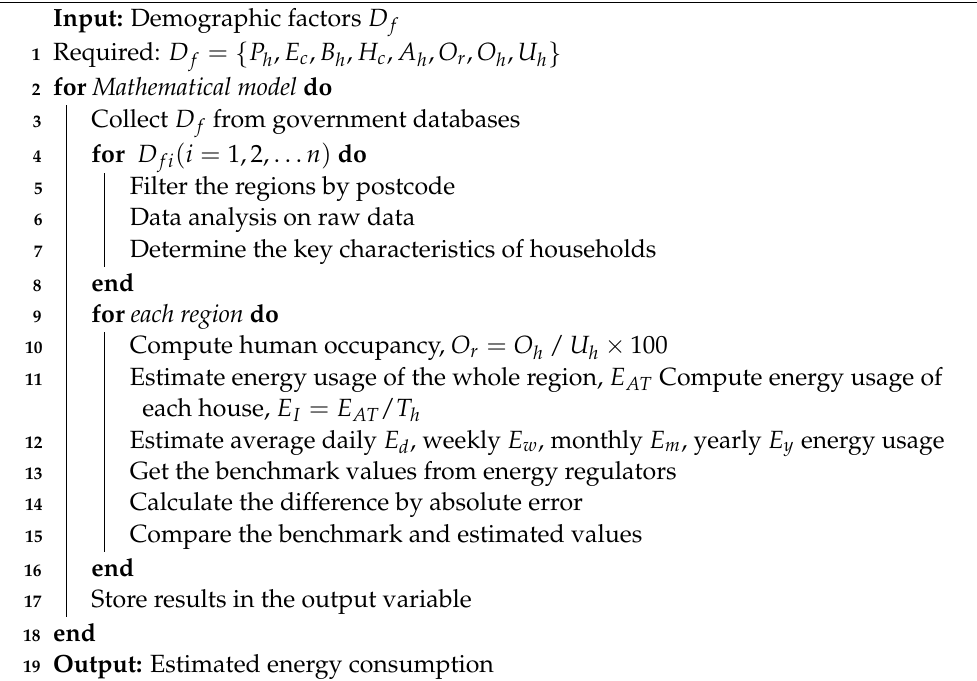
Algorithm 1: Modeling residential energy